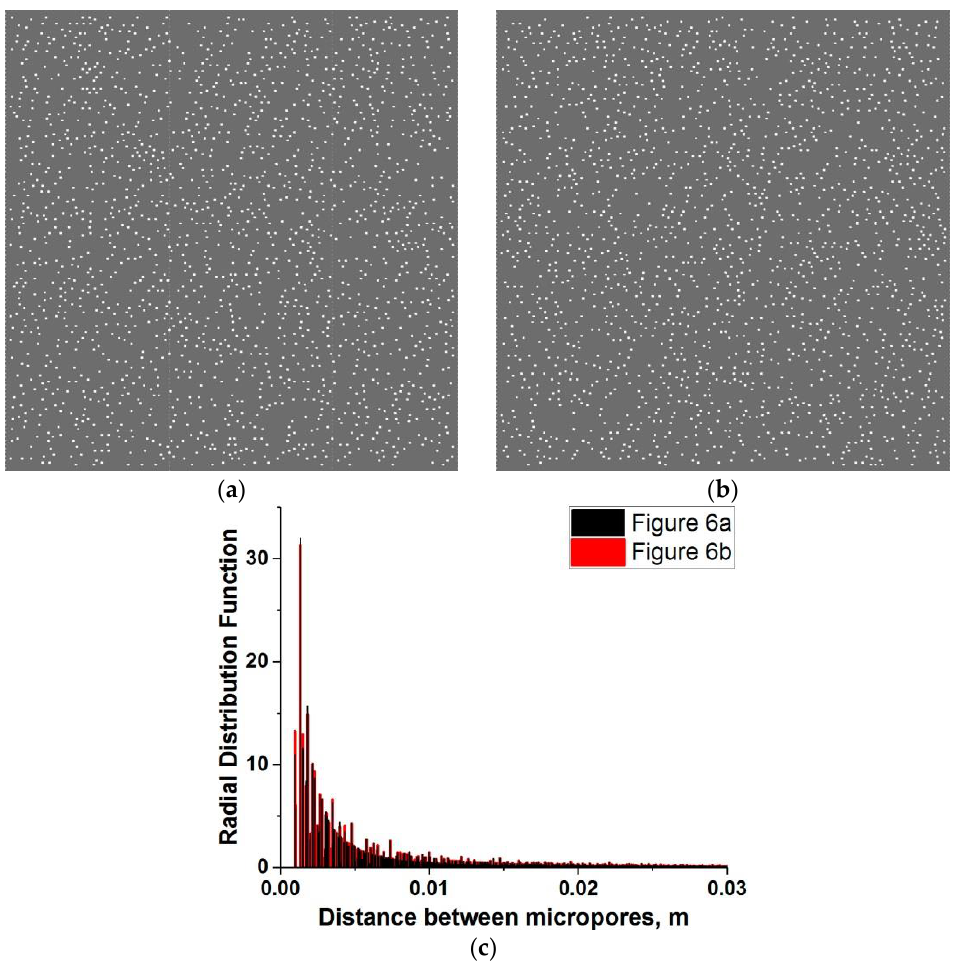
Figure 6. Examples of the initial structure of fluid-saturated microporous (4 vol.%) samples of ce- ment stone with different spatial arrangements of micropores ( a , b ) and corresponding radial distribution functions of micropores ( c ).